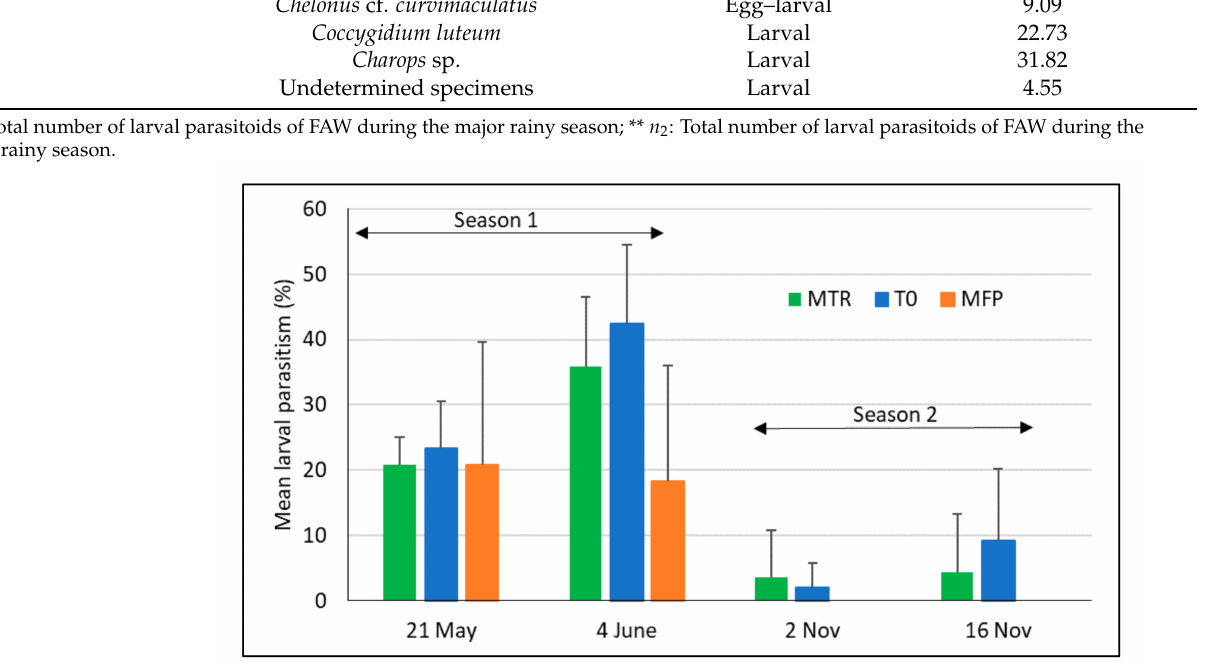
Figure 7. Mean parasitism of FAW larvae (+SD) during the two maize growing seasons in Ghana in 2020. MTR = T. remus release plots; T0 = plots without T. remus releases, no pest